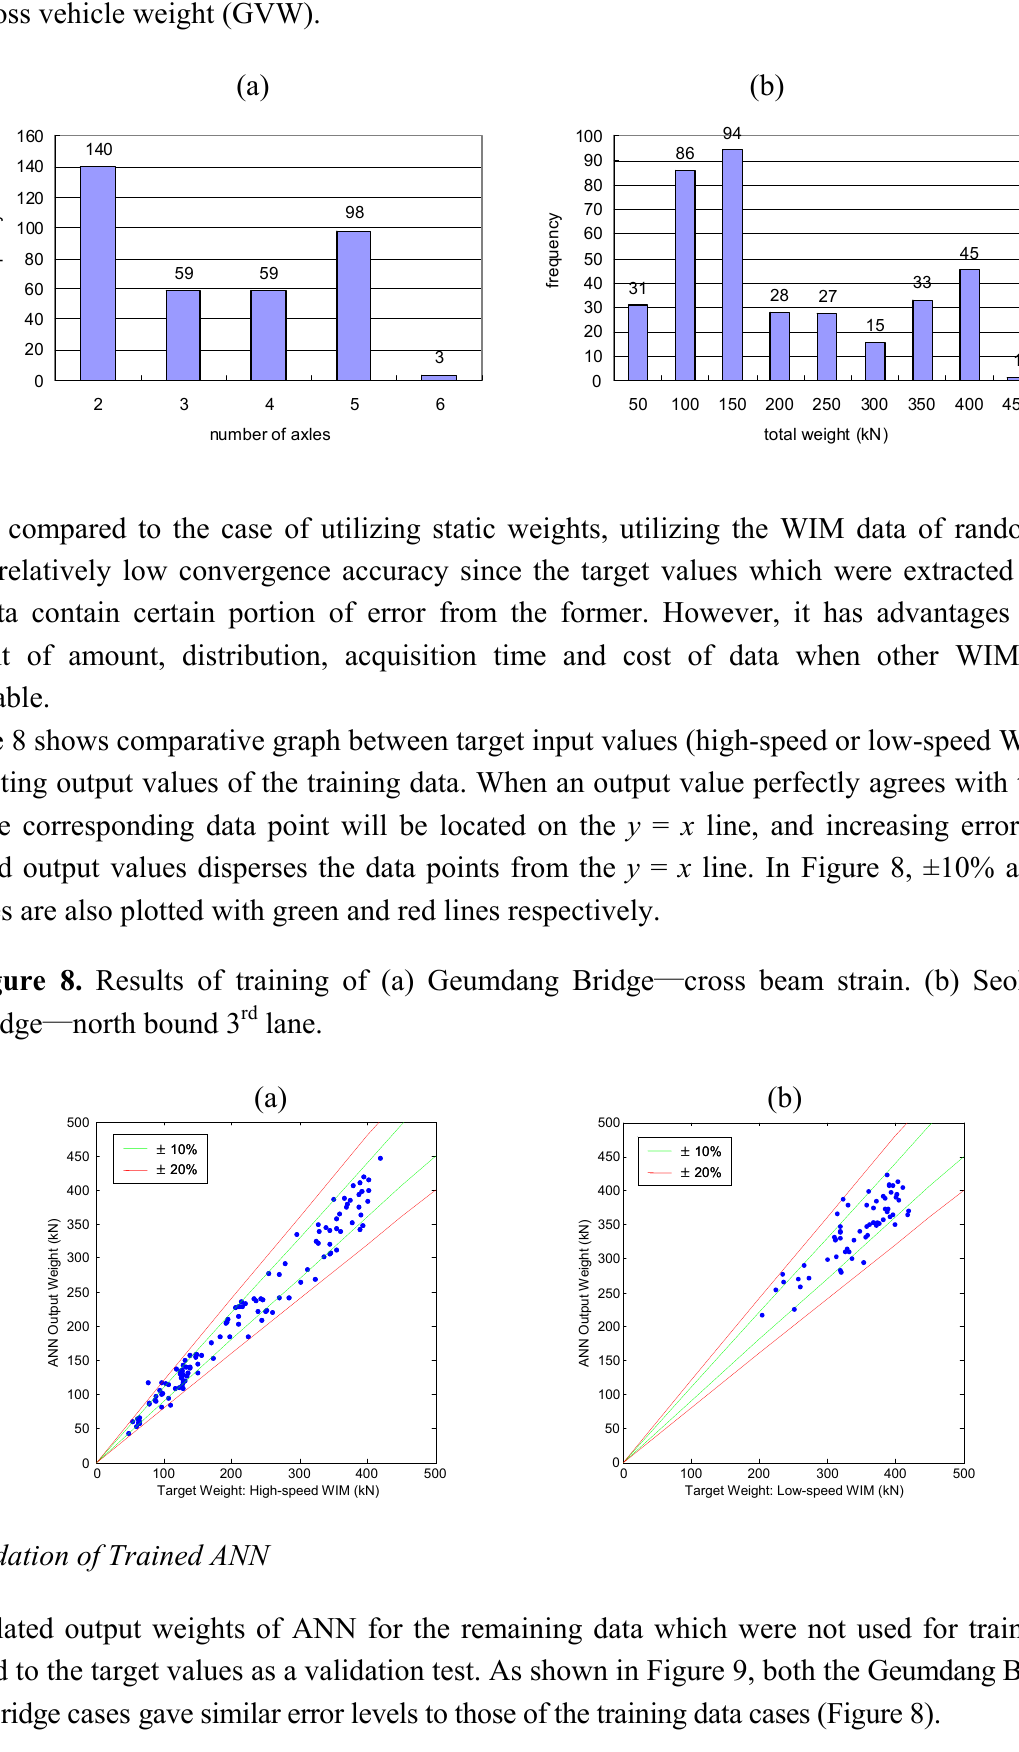
Figure 7. Geumdang Bridge random truck cases’ histogram of (a) Number of axles. (b) Gross vehicle weight (GVW).